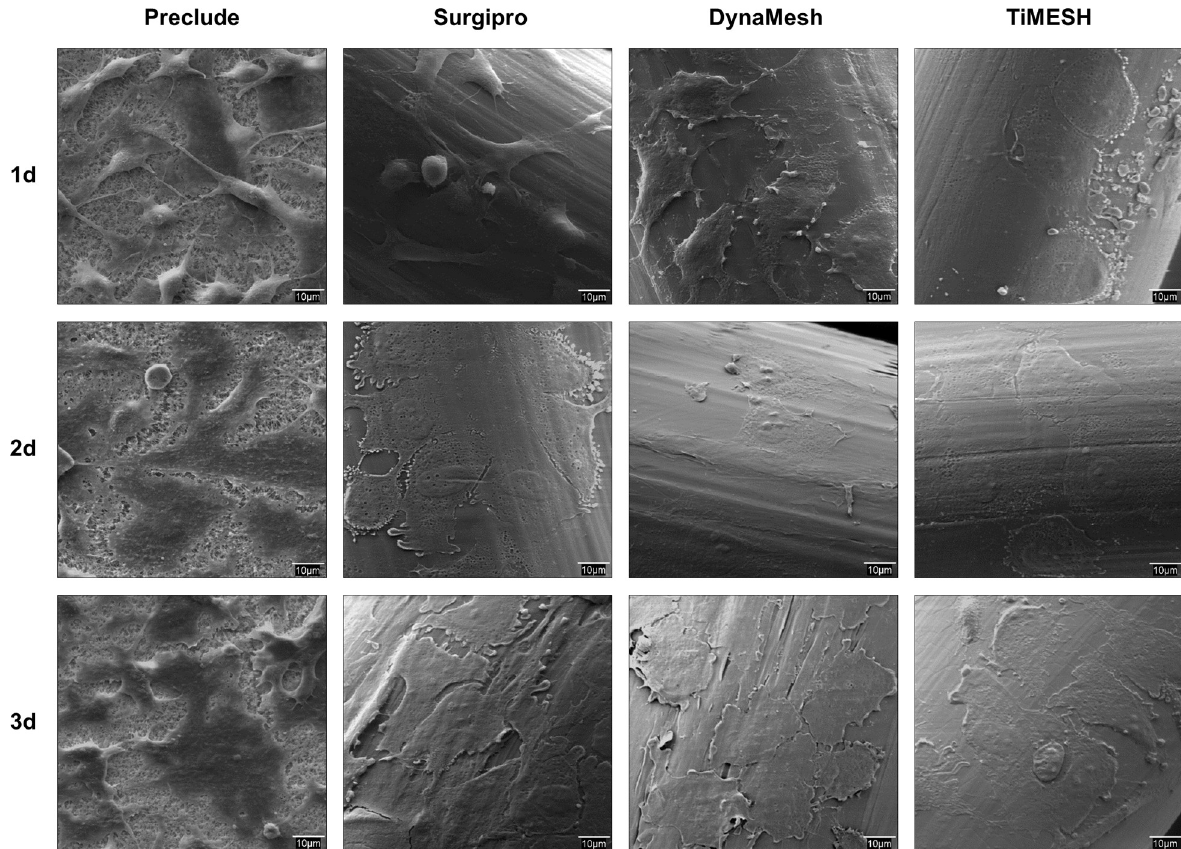
Fig 3. In vitro mesothelialization of meshes. Scanning electron microscopy (1000x magnification) of the mesh fragments seeded with omental mesothelial cells. The micrographs are representative of every study group: Preclude (laminar e-PTFE); Surgipro (bare reticular PP alone), DynaMesh (PP interwoven with PVDF) and TiMESH (PP coated with titanium) at 1, 2 and 3 days after seeding.